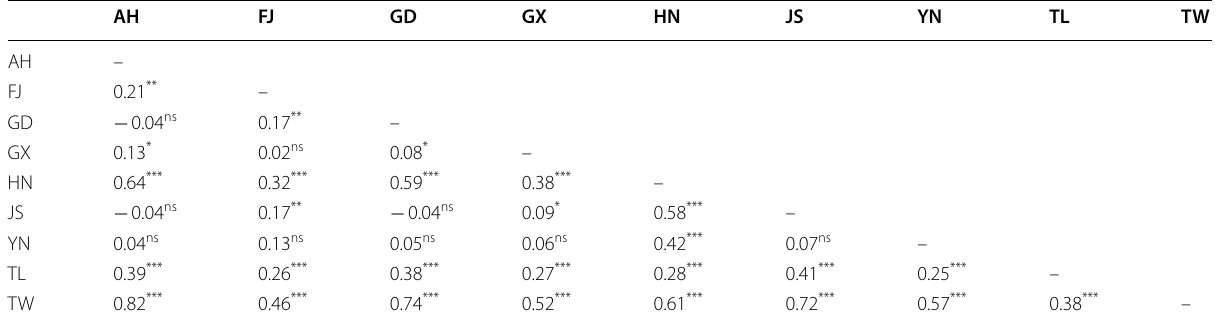
Table 1 Pairwise F between TelMV subpopulations within Clade 1 ST